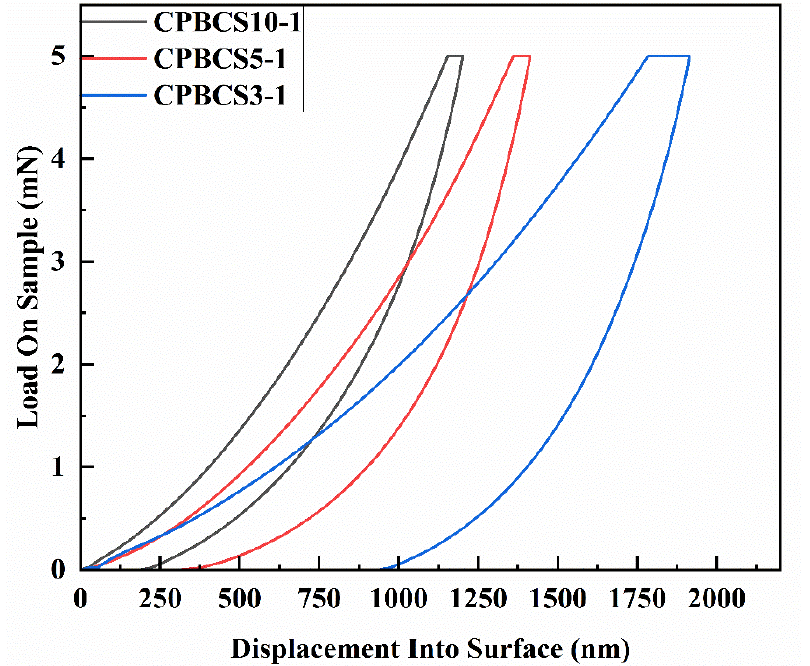
Figure 9. Nanoindentation curves of crosslinked CPBCSs.